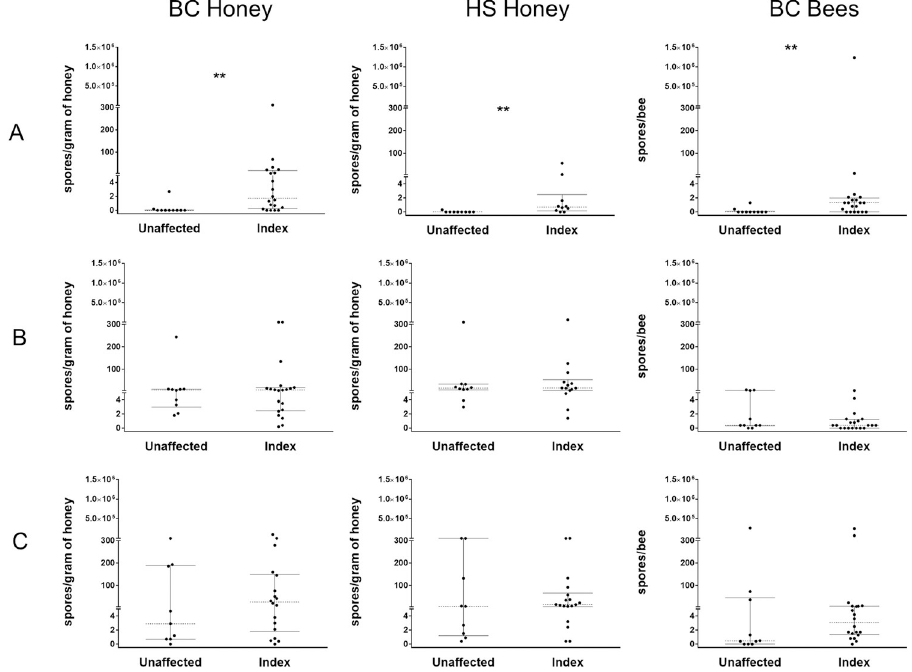
Fig 2. Concentrations of Paenibacillus larvae spores for individual hives from index and unaffected apiaries. A single index apiary and single unaffected apiary were sampled from each operation (six apiaries total). Apiaries are grouped vertically by sample type (BC honey, HS honey, and BC bees) and horizontally by beekeeping operation (A, B, and C; letters denote operation ID). Dotted lines represent median values and bars represent interquartile ranges. �� denotes statistical significance where p < 0.01 (Wilcoxon rank sum